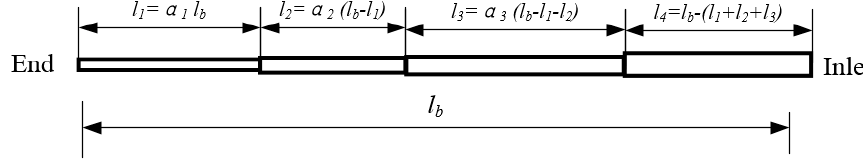
Figure 5. Sketch of a branch pipe. Table 1. Unit prices of different pipes.